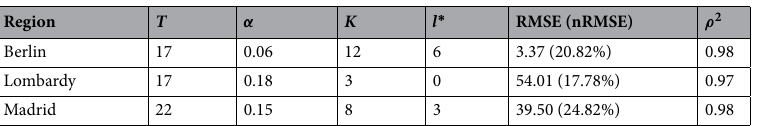
Table 1. Parameters for the best model fit separately for Berlin, Lombardy, and Madrid. T , number of days for which the model was fitted; α , ICU rate; K , stay in ICU; l ∗ , time lag between positive testing and entering the